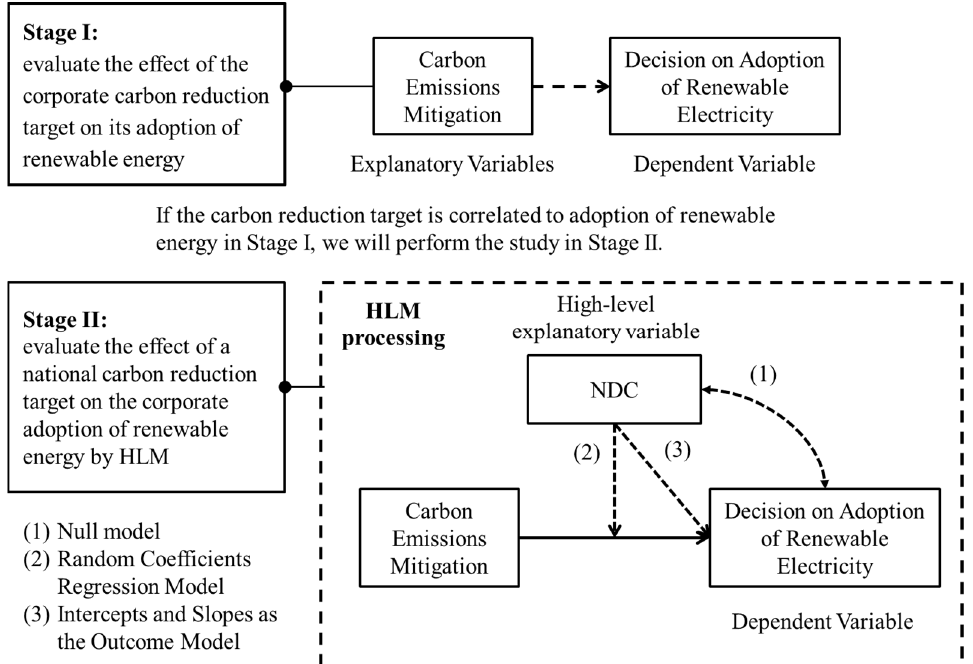
Figure 1. The flowchart of the methodology.